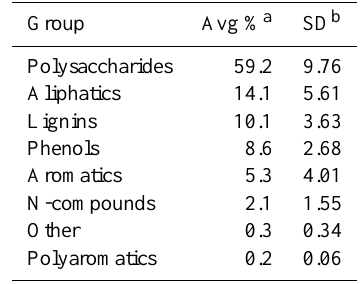
Table 2. Groups of pyrolysis products in peat samples of